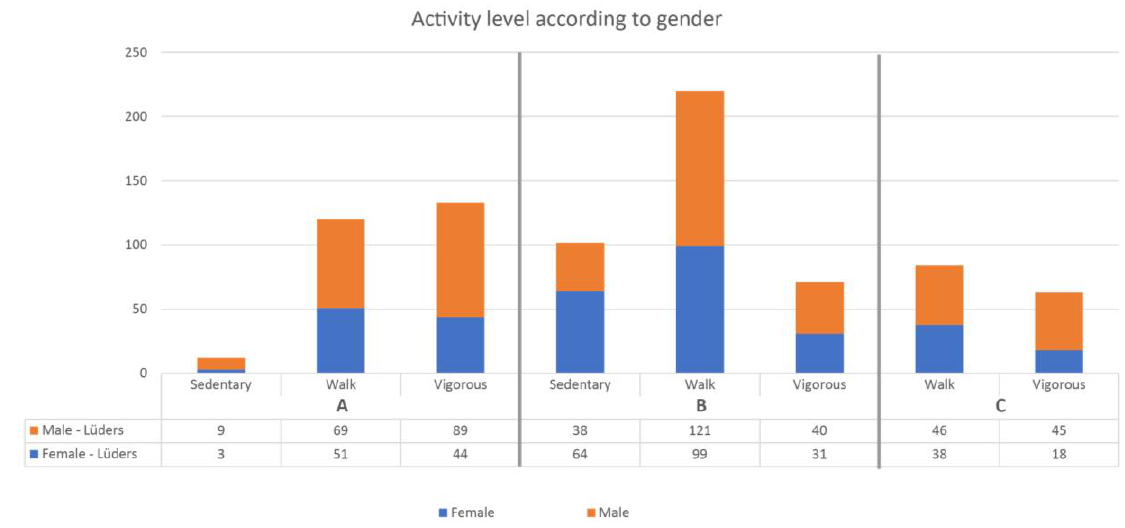
Figure 4. Observed gender distribution across the sub-areas of the space. It can be seen that there is the most vigorous activity in sub-area A.